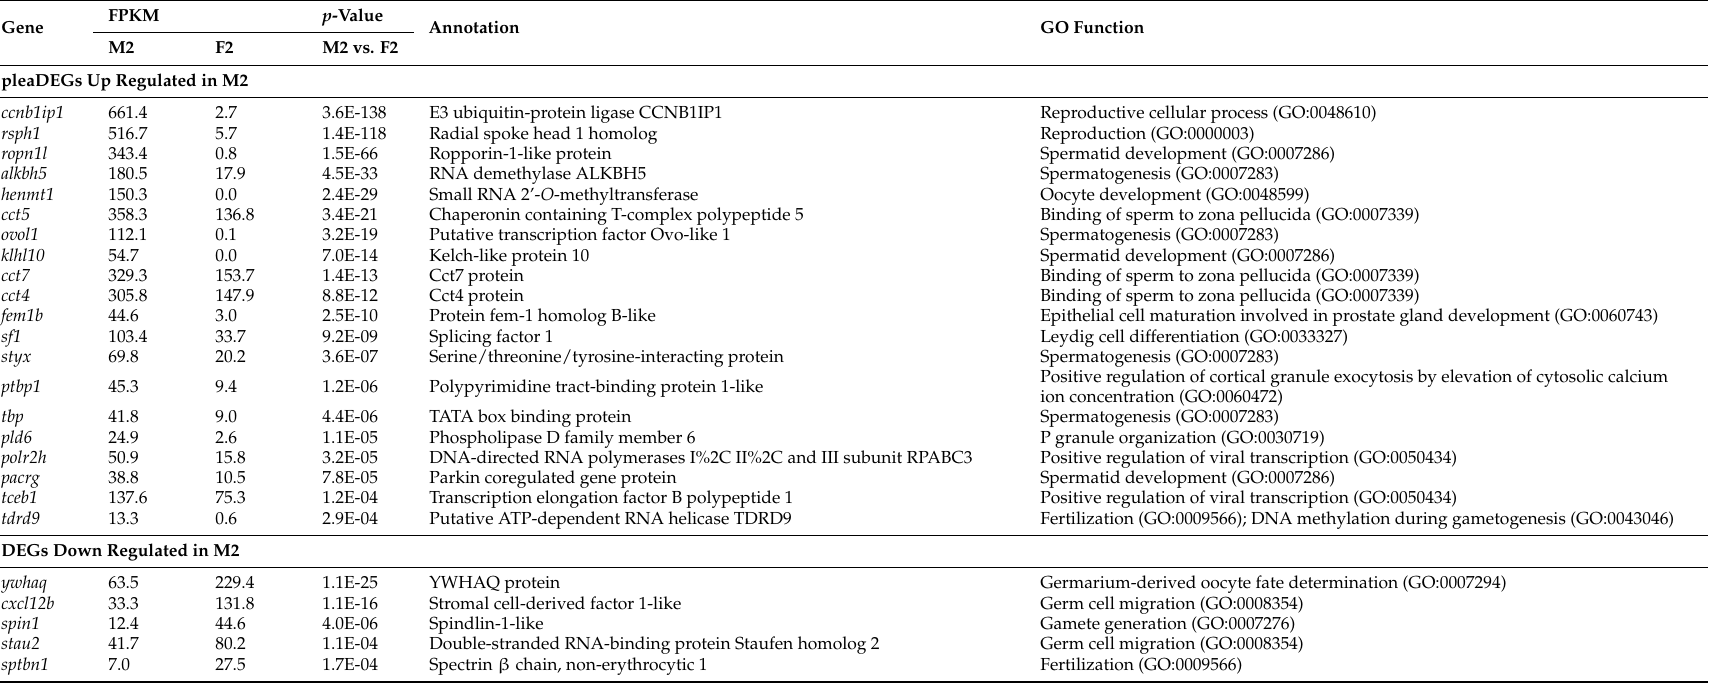
Table 3. Differentially expressed genes (DEGs) in two-year-old tongue sole potentially associated with